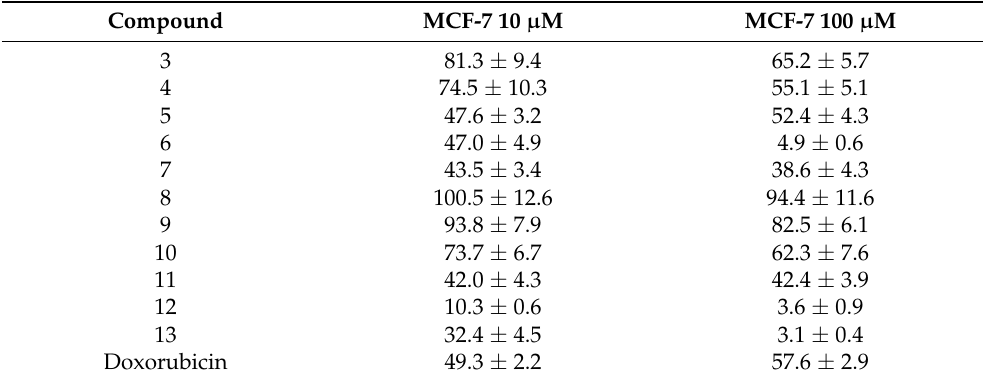
Table 1. 10 and 100 µ M treatments in MCF-7 cells with the synthesized